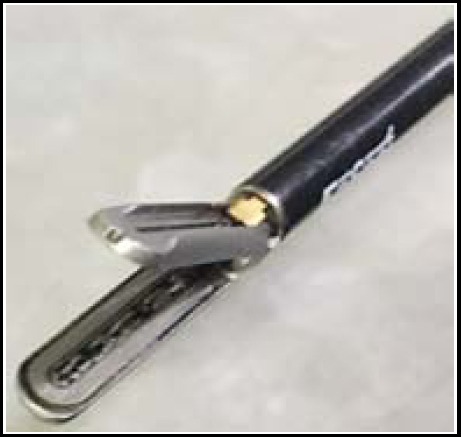
The Ligasure Device